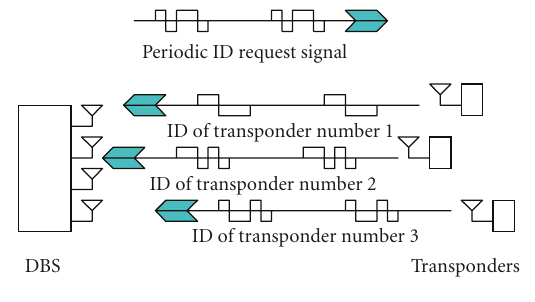
Figure 1: WLPS basic